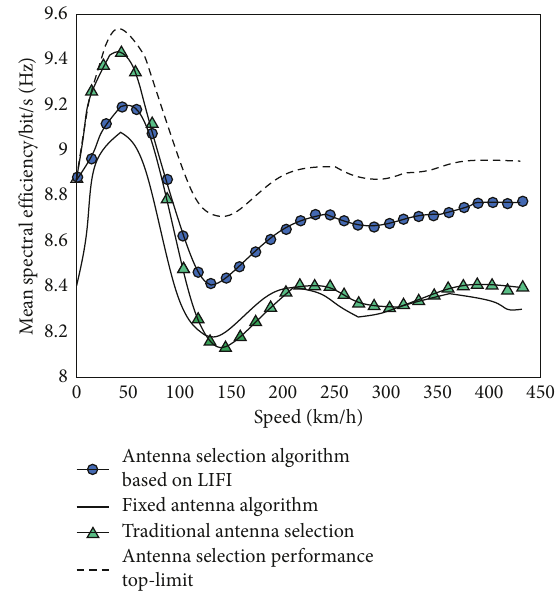
Figure 9: Average spectral efficiency simulation results